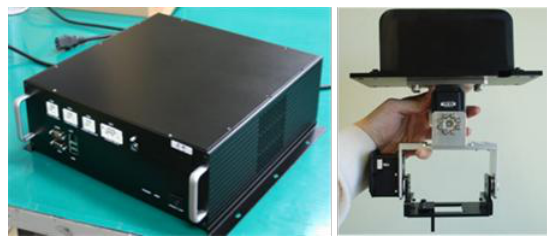
Figure 4. Prototypes of the OBC and gimbal